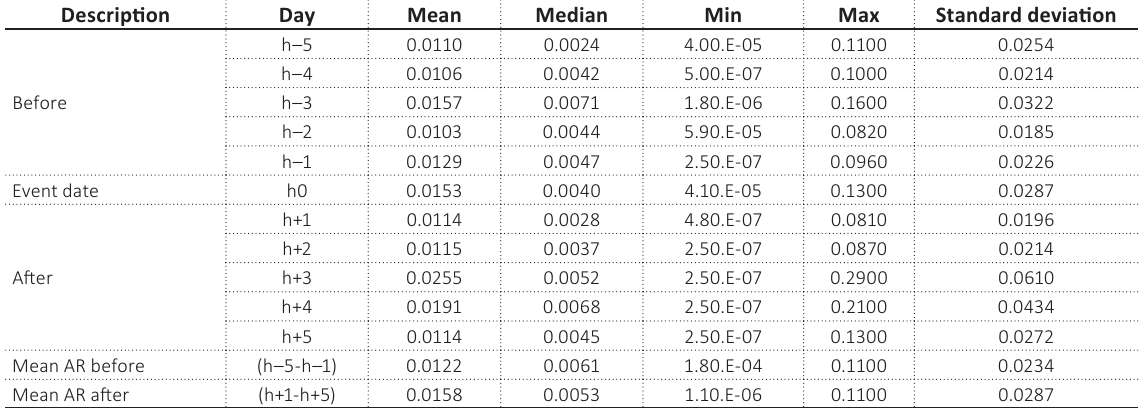
Table 4. Statistical description of trading volume activity